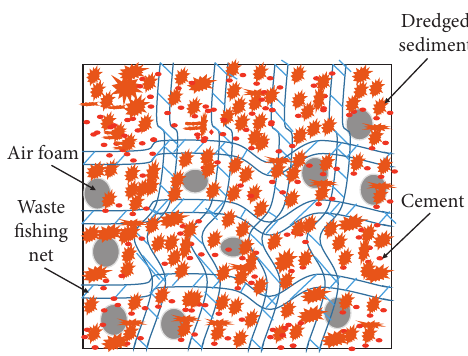
Figure 1: Mix design of stabilized dredged sediments using ce- ment, air foam, and waste fishing net according to